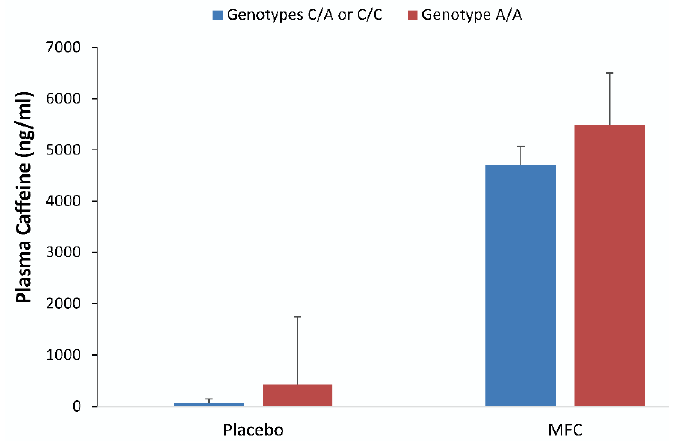
Figure 5. Plasma ca ff eine concentrations measured in samples drawn at 16:00 for those with genotypes C / A or C / C ( n = 6), and genotype A / A ( n = 11) in the placebo and MFC trials (mean ± SD). Both groups had significantly higher ca ff eine concentrations when comparing MFC and placebo trials ( p < 0.001). The di ff erence in trial contrasts between genotype groups was not statistically significant ( p = 0.56).